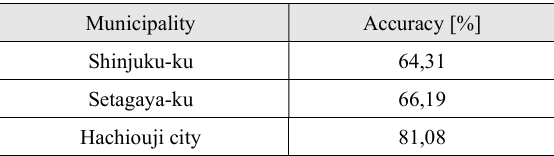
Table 9 Accuracy for each municipality